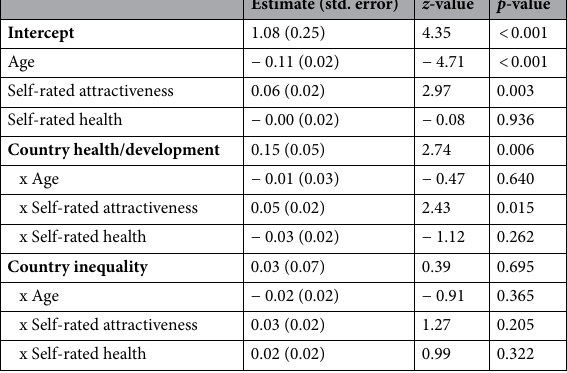
Estimate (std. error) z -value p